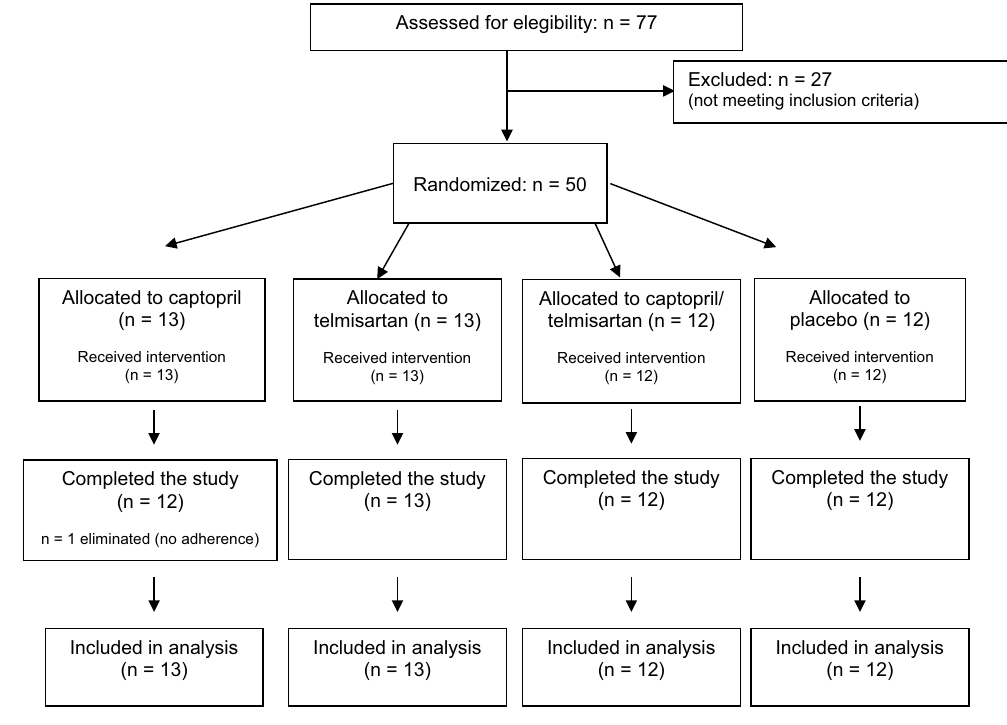
Figure 1. Flowchart of the clinical trial.